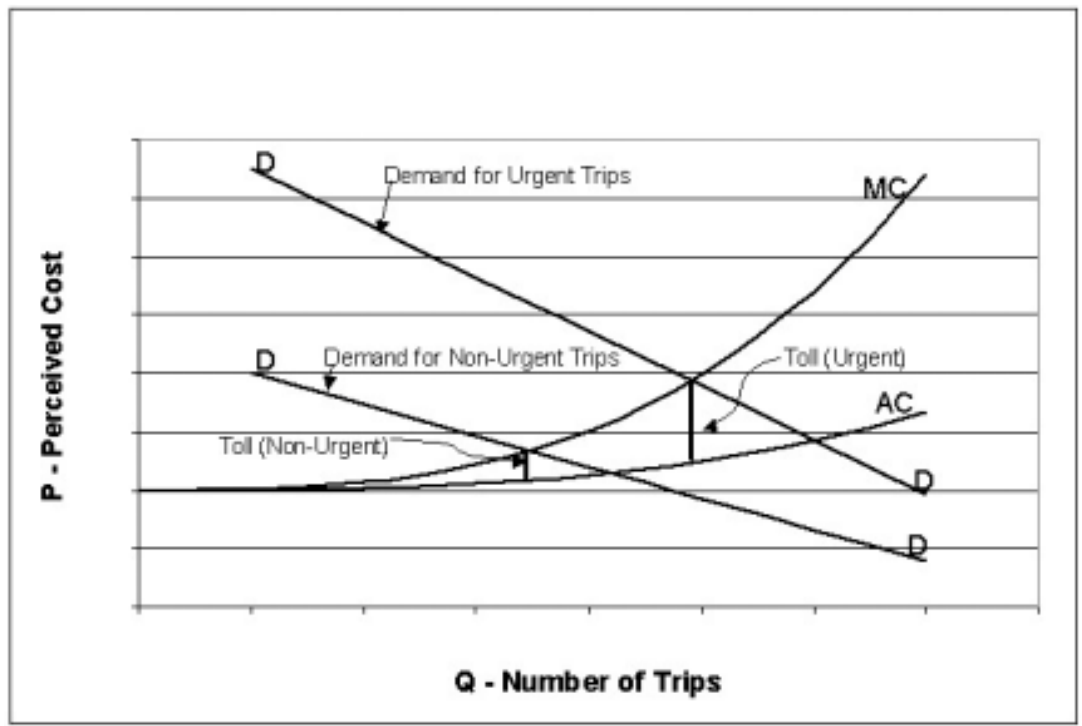
Figure 2. Theoretically Optimum Tolls with Market